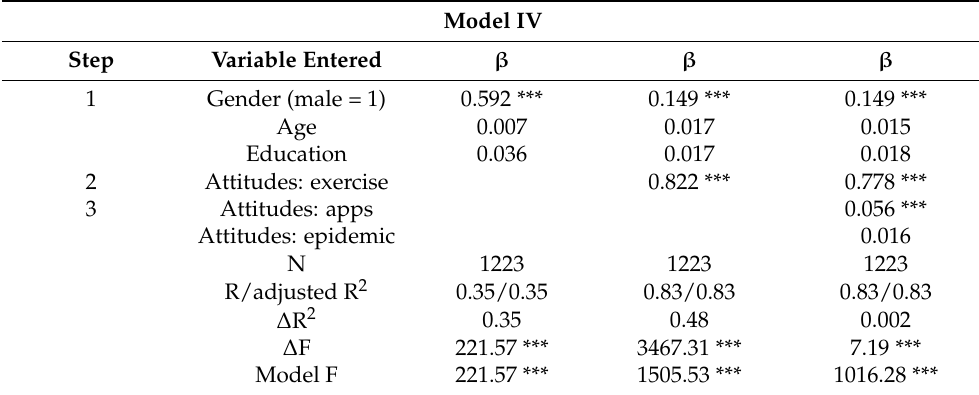
Table 4. Multiple linear regression of intention to use exercise behaviours (or PA) to resist COVID-19. Model